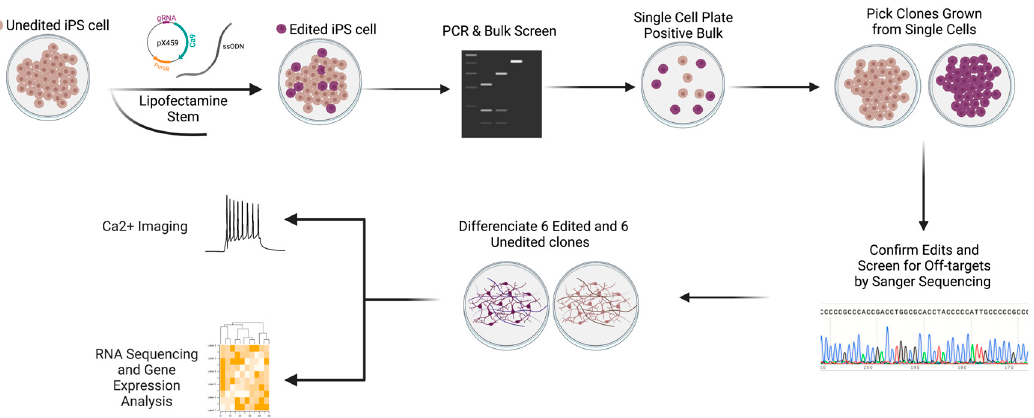
Figure 3. Experimental design and flow of CRISPR editing. Unedited iPS cells were transfected by lipofection with pX459 plasmid, which included a clone in sgRNA, Cas9, and a puromycin resistance gene along with an ssODN containing the changes. Bulk populations of cells were screened by PCR and restriction digestion to look for indications of successful editing. Wells with mixed populations of edited and unedited cells were sparsely plated into single cells. Clones grown from single cells were screened for the edit by Sanger sequencing. Six edited and six unedited clones were chosen and screened for off target edits. The same clones were differentiated into glutamatergic neurons using NGN2. Edited and unedited cells were compared by calcium imaging and RNA sequencing.